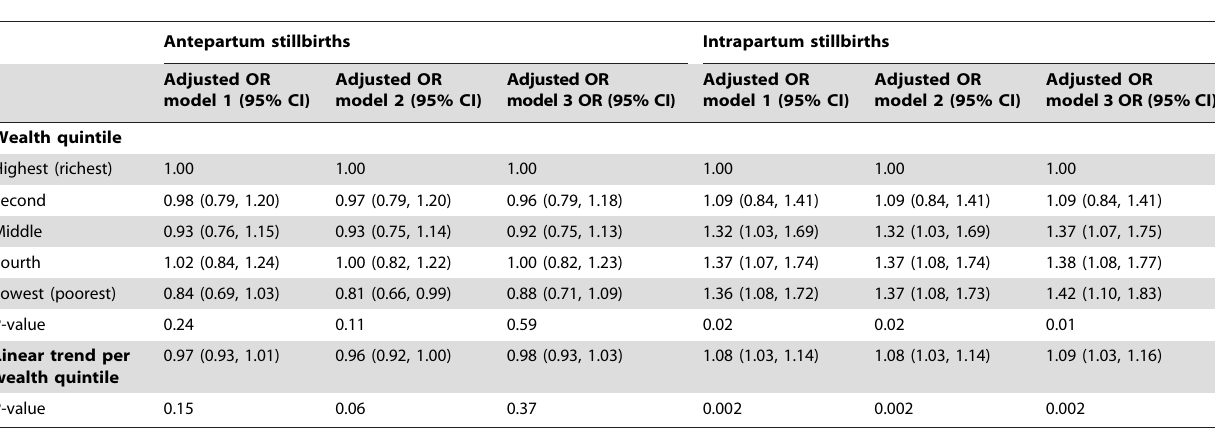
Table 4. Associations between stillbirths and maternal socioeconomic status, 1 July 2003 to 30 September